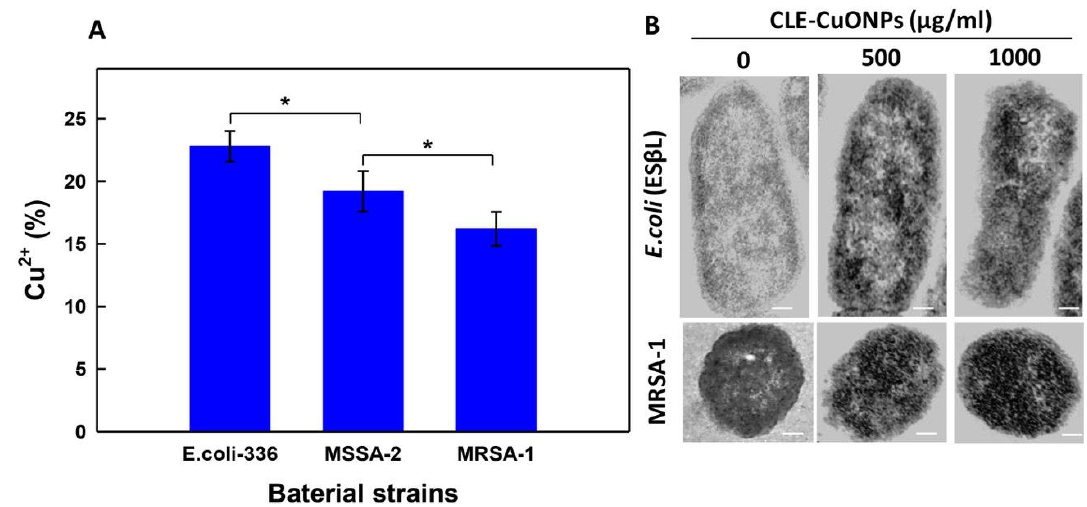
Figure 8. AAS detection of intracellular accumulation of Cu 2+ . ( A ) shows intracellular accumulation of Cu 2+ in E. coli -336, MSSA-2 and MRSA-1. Asterisks represent significance at p < 0.05 , while error bars represent SD of triplicate samples; ( B ) demonstrate the TEM micrographs of E. coli- 336 and MRSA-1 exposed to CLE-CuONPs (500–1000 µg/mL) indicating the intracellular NPs accumulation, and cellular damage. Scale bar = 200 nm.